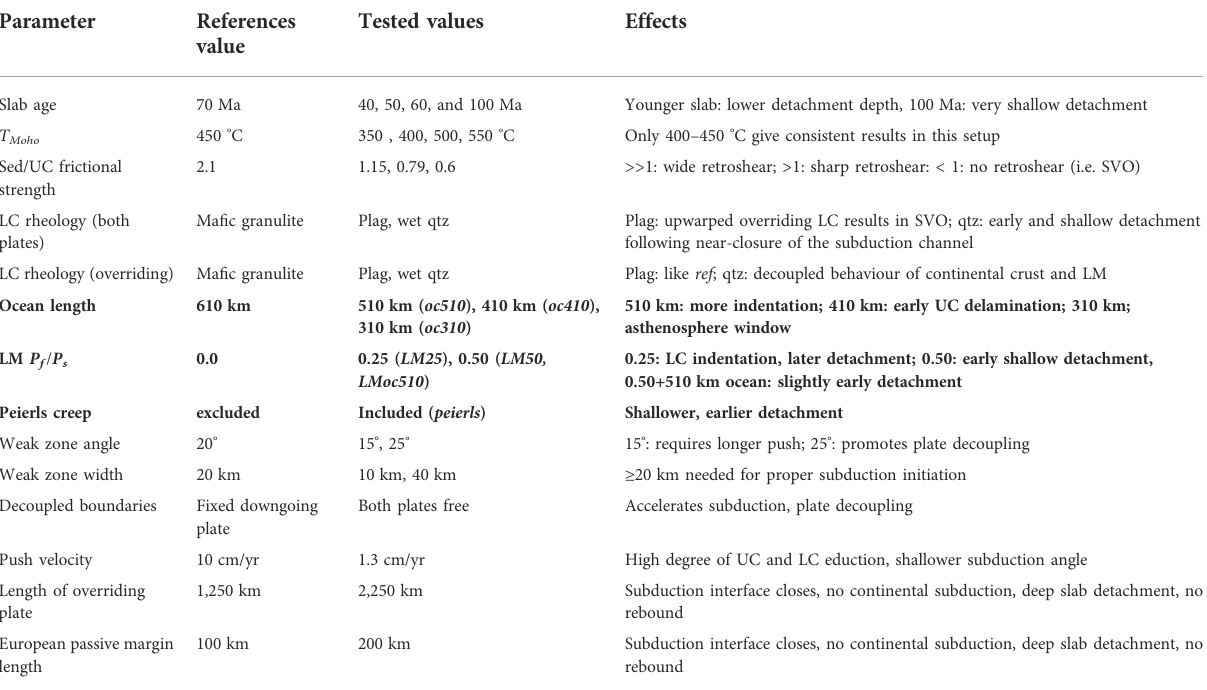
TABLE 2 Summary of all tested parameters and their effects with respect to the reference results. The parameters discussed in detail are written in bold. Abbreviations: SVO: single-vergent orogen, qtz: quartzite, sed/UC frictional strength: ratio between brittle strength of sediments over upper continental crust at 10 MPa, LC: lower crust, LM: lithospheric